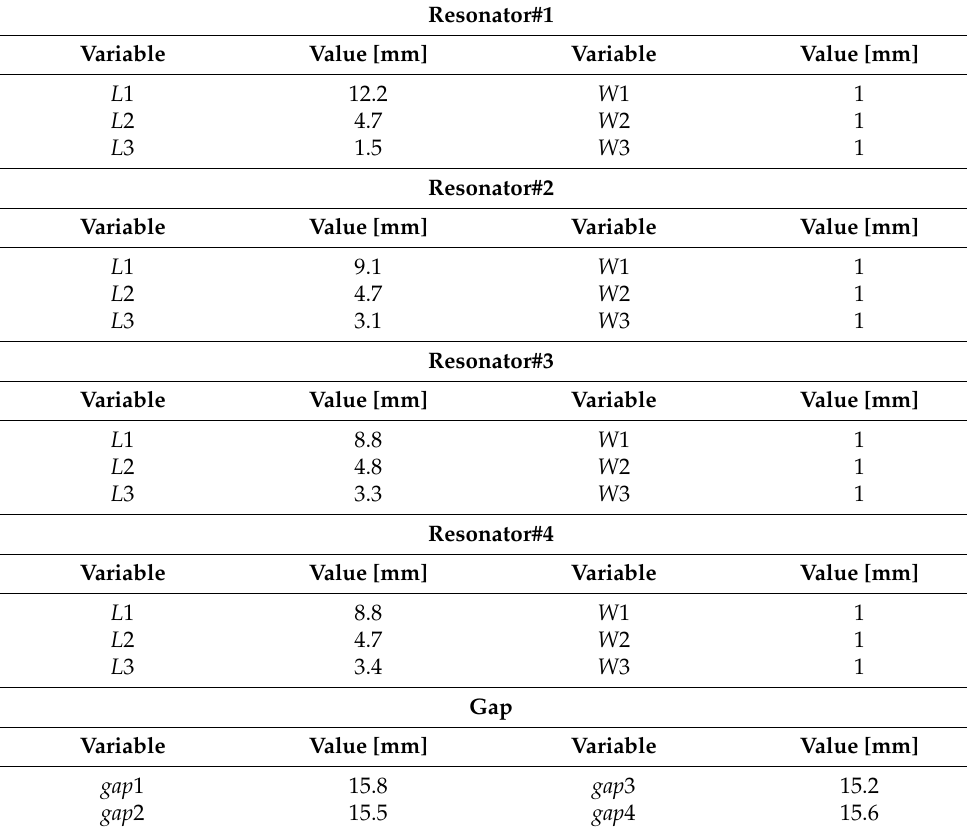
Table 6. The values of the physical dimensions of the eighth-order